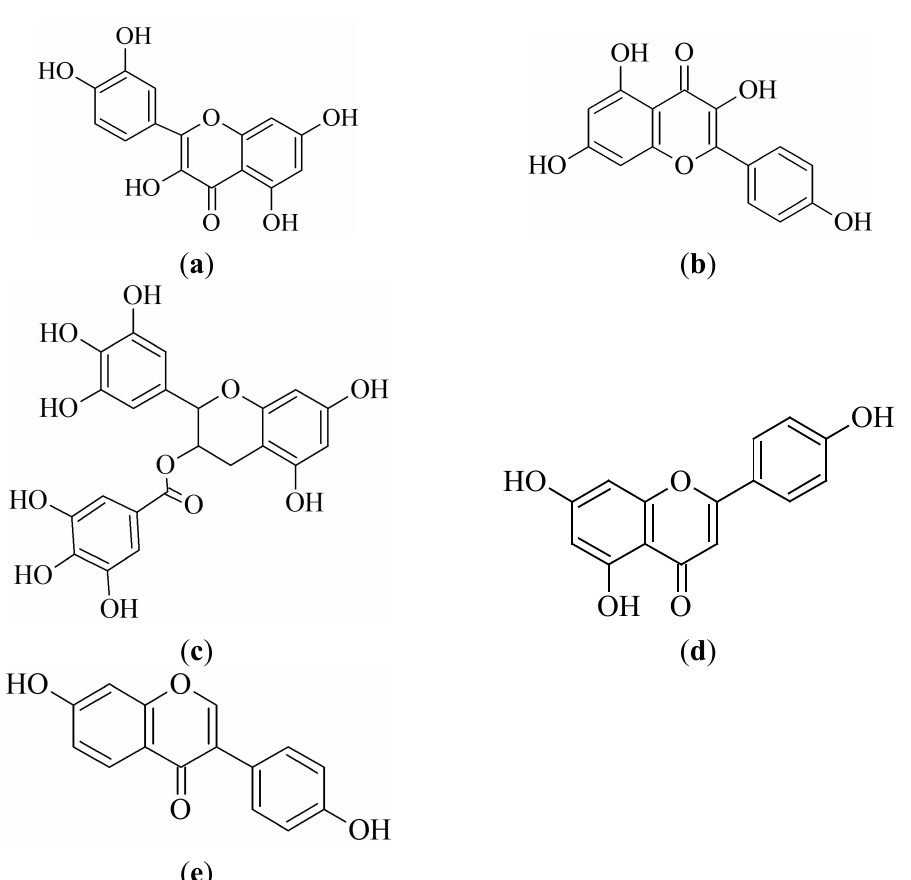
Figure 2. Chemical structures of selected flavonoids possessing anti-cancer